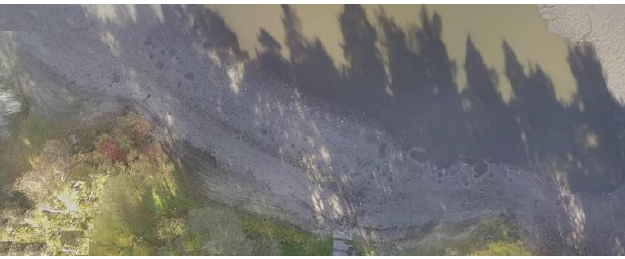
Fig. 8: Launched pond Pohranov in 2.11.2015, source: authors Firstly, changes of size of shorelines in monitored time period are calculated. In the Table 1, there are visible changes in metres (Shape_change) and percentage (Shape_change_%) in monitored time period. The values regarding length are extracted from the software, values regarding change are calculated by authors. Table 1: Shoreline changes in metres and percentage, source: